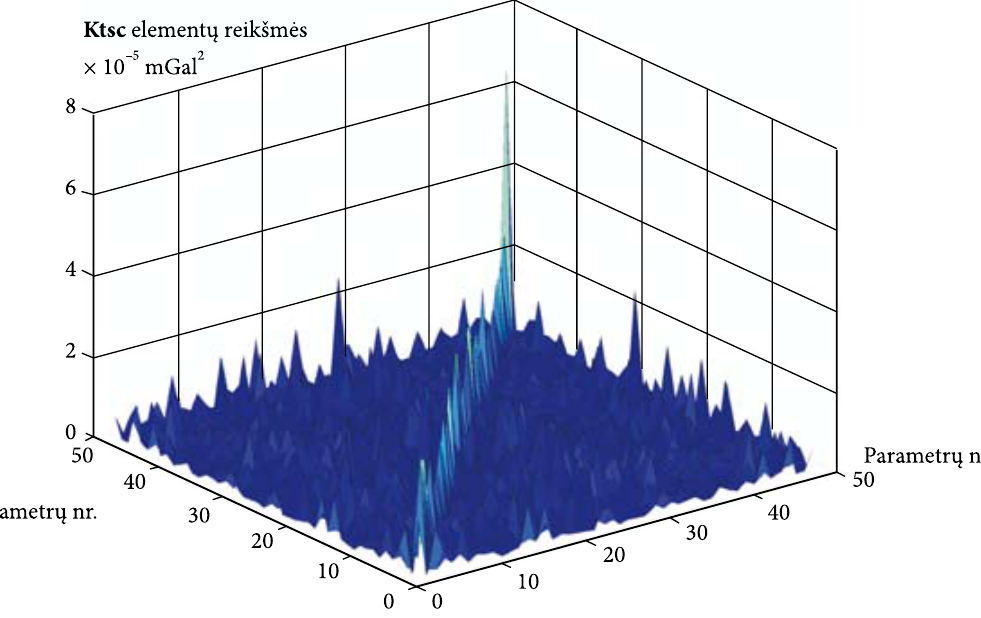
Fig. 3. Graphic view of adjusted parameters of gravity value vector (4th model) of the covariance matrix Ktsc